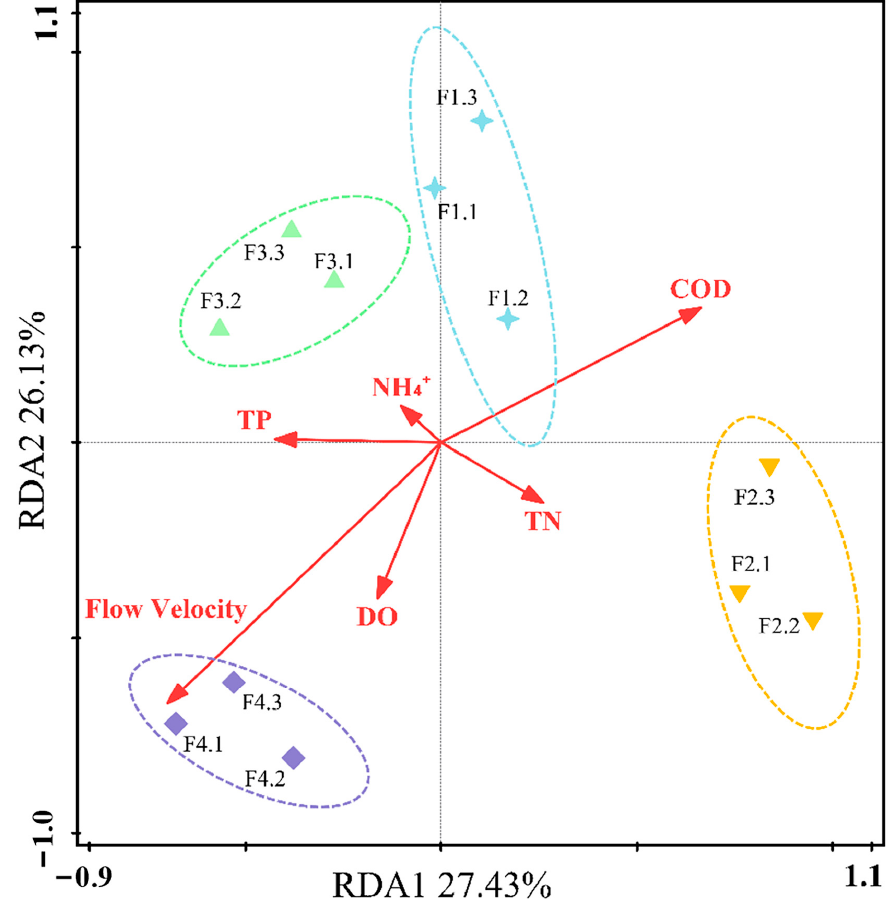
Figure 6. Biplot diagram of redundancy analysis (RDA) of benthic algae biomass, abundance, and environmental variables. Red vectors: environmental factors, color ellipses: grouping ellipses of F1, F2, F3, and F4 repeated samples.